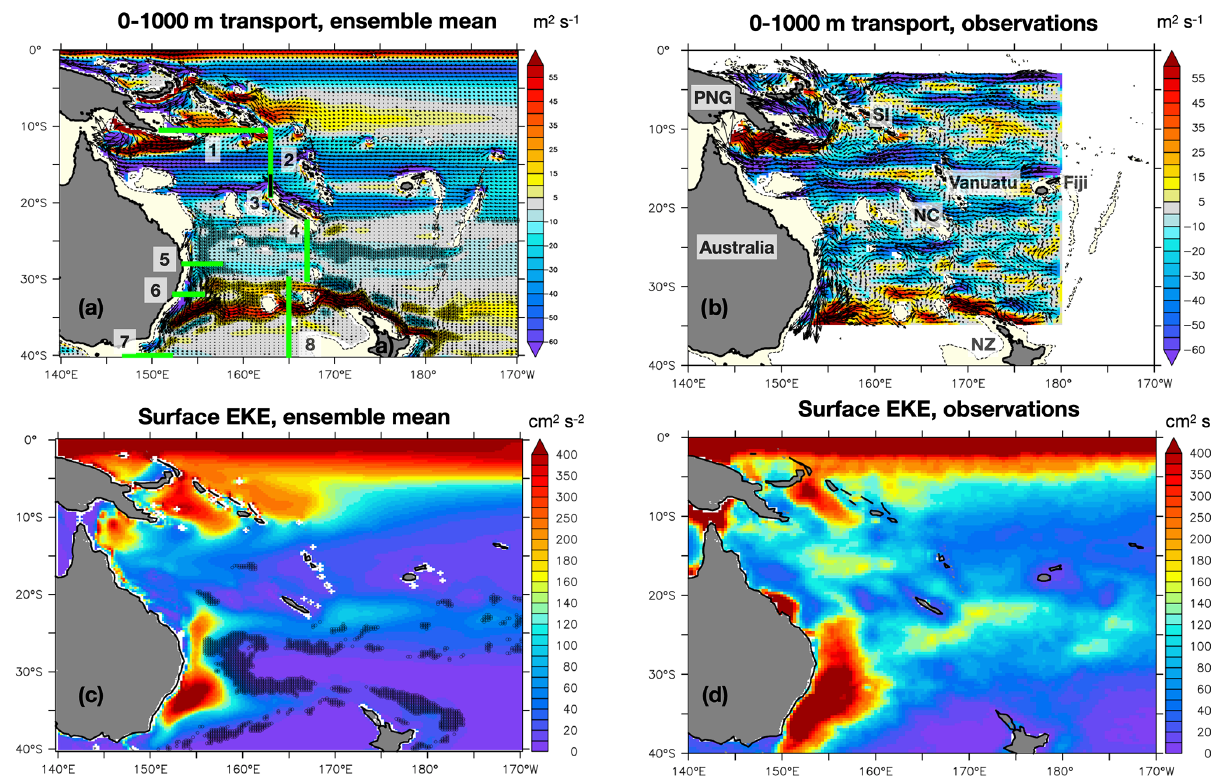
Figure 2. (a) The 1980–2015 time-averaged 0–1000m transport from the ensemble mean. Colors show zonal transport (positive values mean eastward, negative values westward), and arrows show total transport. The hatched areas show regions where the spread of the 1980–2015 time-averaged 0–1000m transport is at least 15% of the ensemble mean. The thick green lines (and the thick black line) show the main current sections shown in Fig. 4, with the associated numbers corresponding to the caption of Fig. 4. (b) 0–1000m transport from the Argo- Merged observations; colors show zonal transport. The names of the main islands are also indicated. NC: New Caledonia; NZ: New Zealand; SI: Solomon Islands and PNG: Papua New Guinea. (c) Time-averaged ensemble mean of the 1980–2015 surface EKE. The hatched areas show regions where the spread of the 1980–2015 EKE is between 10% and 20% of the ensemble mean. (d) 1993–2015 time-averaged surface EKE from the OSCAR product. Table 1. Computation of the 0–1000m transport of key currents shown in Fig. 4. The numbers correspond to the sections shown in Fig. 2. Number Transport Latitudes Longitudes Sign of the current Solomon Sea entrance Along 10.5 ◦ S 150–162 ◦